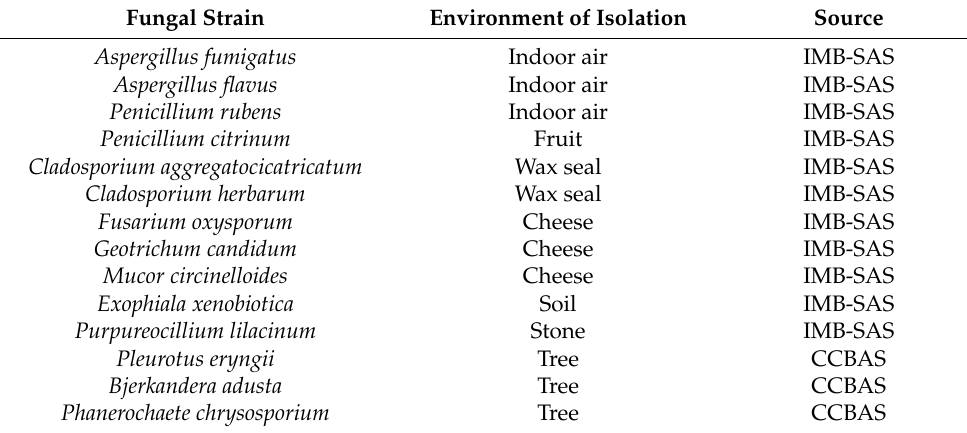
Table 3. Characteristics of the assayed fungal strains.